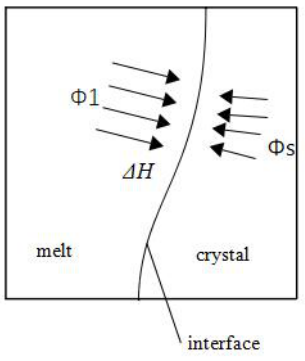
Figure 2. Scheme of the phase interface energy conservation.